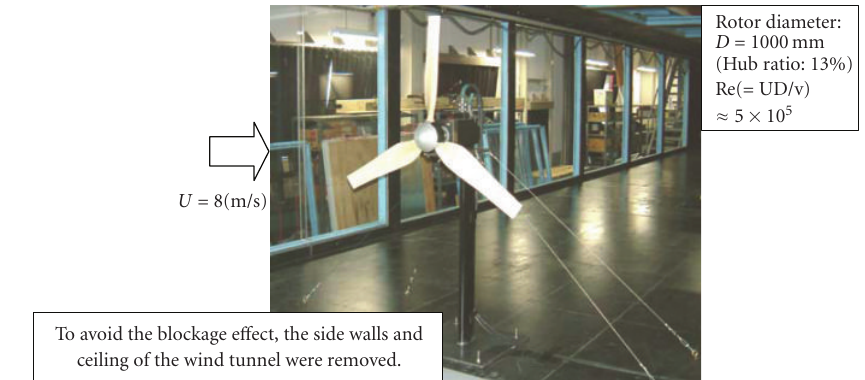
Figure 1: View of the small-scale WTG in the wind tunnel.